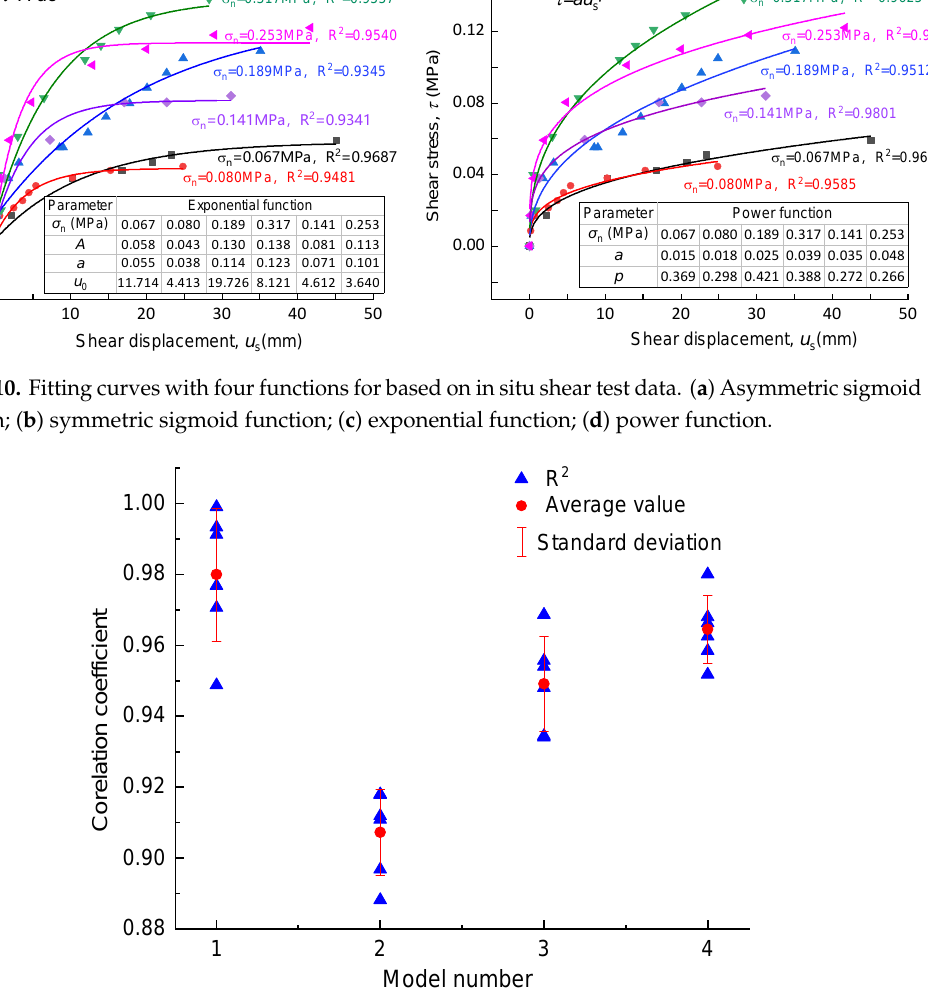
Figure 11. Correlation coefficients for different functions. 1 Asymmetric sigmoid function; 2 symmetric sigmoid function; 3 exponential function; 4 power function.